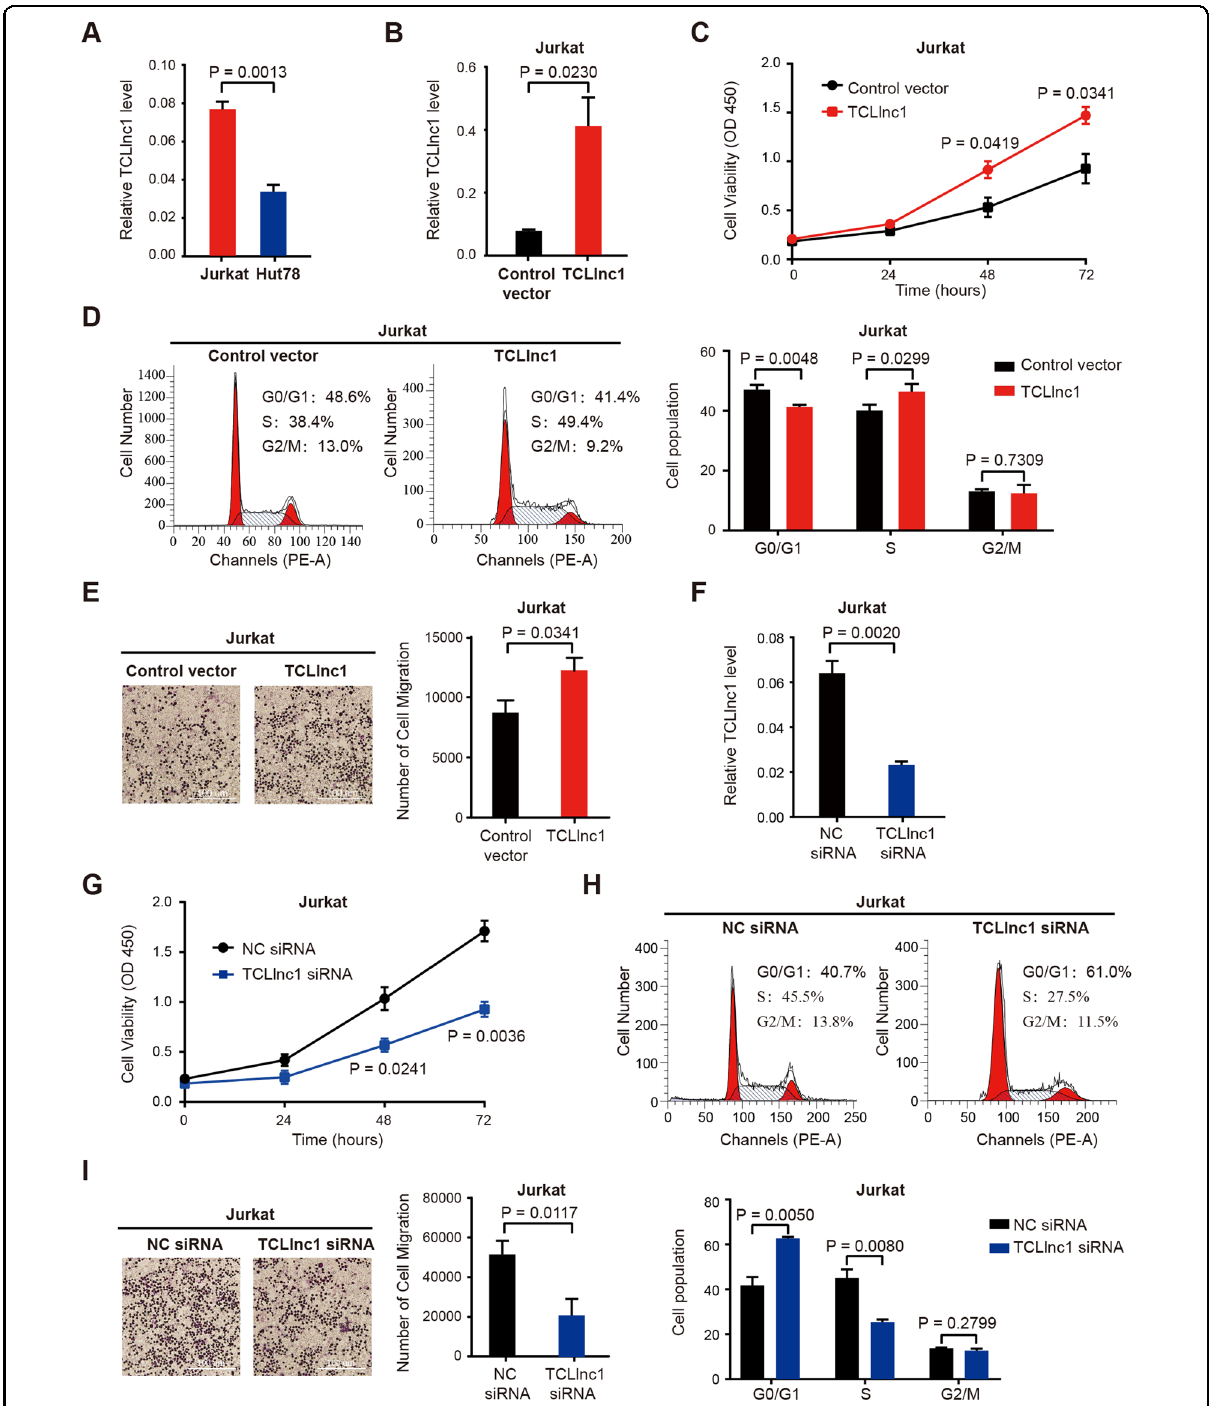
Fig. 3 TCLlnc1 promoted T-lymphoma cell proliferation and migration in vitro. A Expression of TCLlnc1 in Jurkat and Hut78 cells by qRT-PCR. B Overexpression of TCLlnc1 on Jurkat cells. C – E Effect of TCLlnc1 overexpression on cell proliferation ( C ), cell cycle ( D ), and cell migration ( E ) of Jurkat cells. Representative fi elds in transwell assay were captured using an inverted microscope (left) and the total number of migrated cells in the lower compartments was counted by fl ow cytometry (right). The scale bar represents 100 μ m. F Knockdown of TCLlnc1 on Jurkat cells. G – I Effect of TCLlnc1 knockdown on cell proliferation ( G ), cell cycle ( H ), and cell migration ( I ) of Jurkat cells. Representative fi elds in transwell assay were captured using an inverted microscope (left) and the total number of migrated cells in the lower compartments was counted by fl ow cytometry (right). The scale bar represents 100 μ